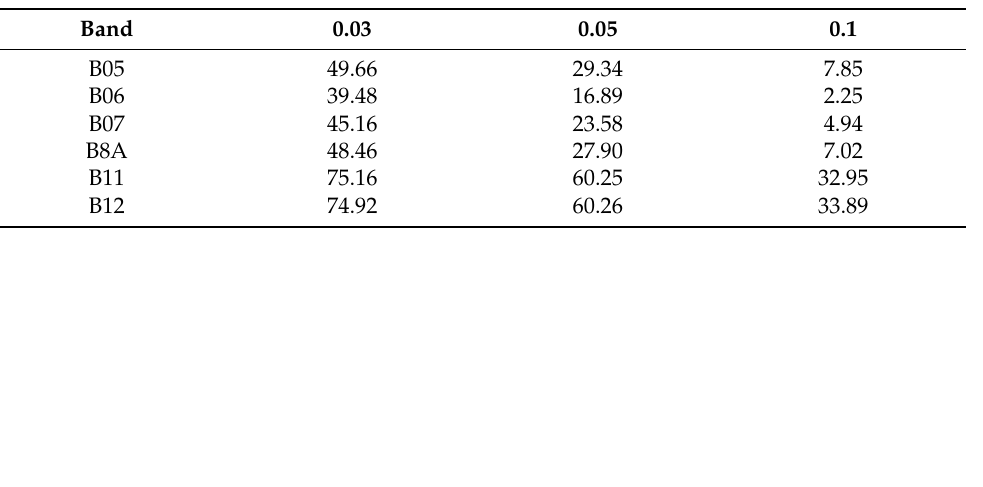
Table 8. Percentage of pixels beyond a given relative error threshold for reflectances in [0, 0.1]